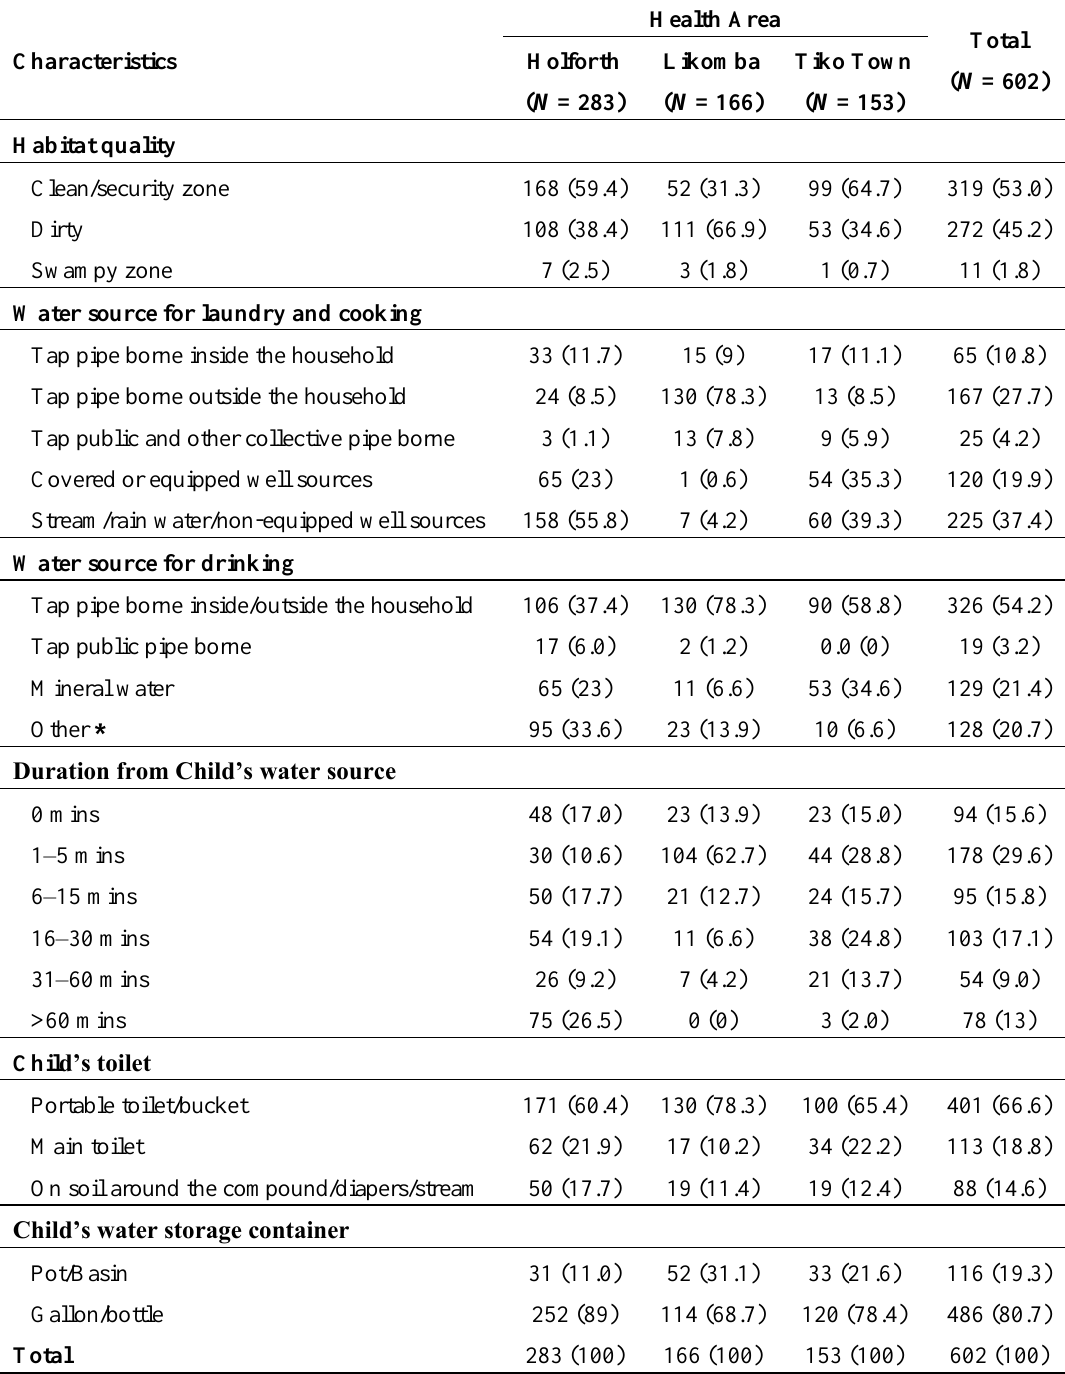
Table 2. Environmental characteristics of households in Tiko City